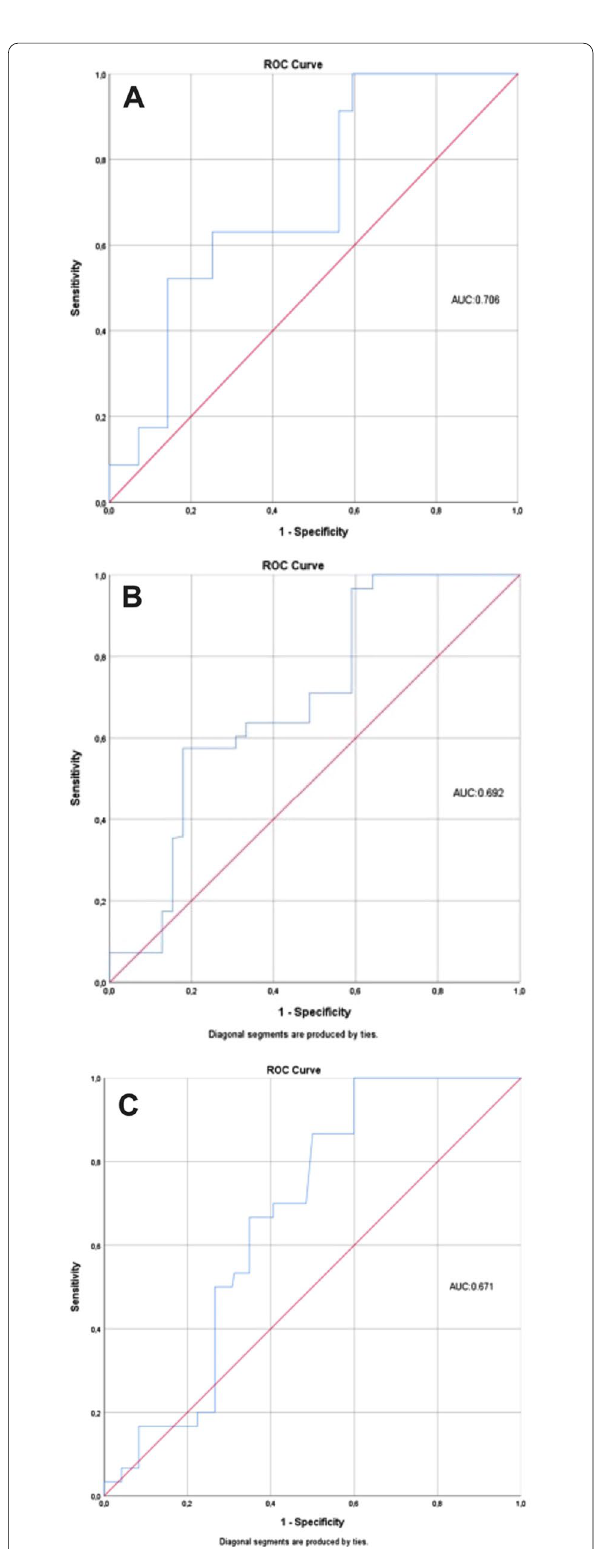
Fig. 1 Receiver operating characteristics curve analysis of AGD AC a , AGD AF b , GH c for predicting stress urinary